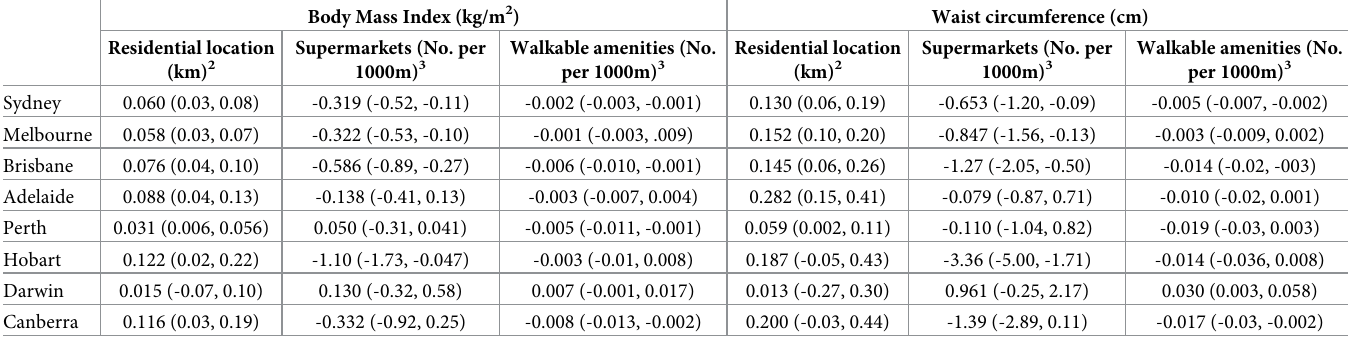
Lastly, walkable amenities and body size were generally negatively associated: BMI was lower and waist circumference smaller in areas with a larger number of local amenities in Syd- ney, Brisbane, Perth (BMI only), and Canberra. Unexpectedly, waist circumference was larger with more local amenities in Darwin. Table 4 presents associations between neighbourhood disadvantage and BMI before and after adjustment for residential distance to the CBD, count of supermarkets, and walkable amenities. Residents of socioeconomically disadvantaged neighbourhoods in Sydney, Mel- bourne, Brisbane, Adelaide, and Perth had significantly higher BMI than residents of the least disadvantaged neighbourhoods (Model 1). Associations between neighbourhood disadvantage and BMI in these capital cities were attenuated after adjustment for neighbourhood proximity to the city’s CBD (Model 2). The magnitude of difference in BMI between the least and most disadvantaged neighbourhoods in Brisbane reduced from 2.11 kg/m 2 to 1.51 kg/m 2 (28.5%) after adjustment for residential distance to the CBD. The corresponding reductions in the magnitude of neighbourhood inequalities in BMI in Adelaide, Melbourne, Sydney, and Perth were 15.4%, 10.5%, 9.0%, and 4.0% respectively. Though coefficients changed relative to Table 3. Associations 1 between residential distance to the CBD, the food environment, walkable amenities, and body mass index and waist circumference, by capital city (bivariate, multilevel linear regression). Body Mass Index (kg/m 2